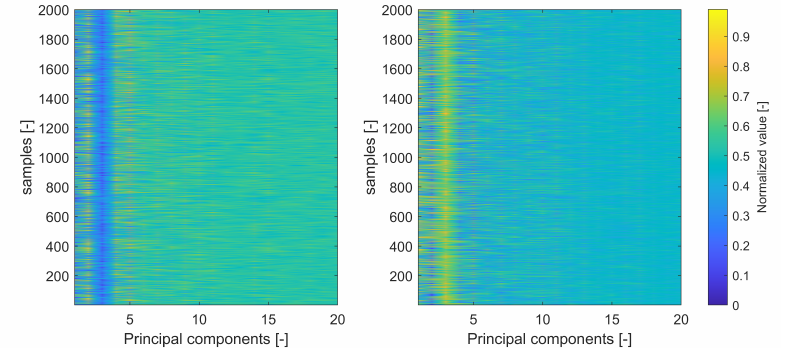
Figure 15. Comparisons between the PCA results in spectrogram images of GNSS ( left ) and spoofer ( right ). The values in the colour bar represent the amplitude levels of the PCA